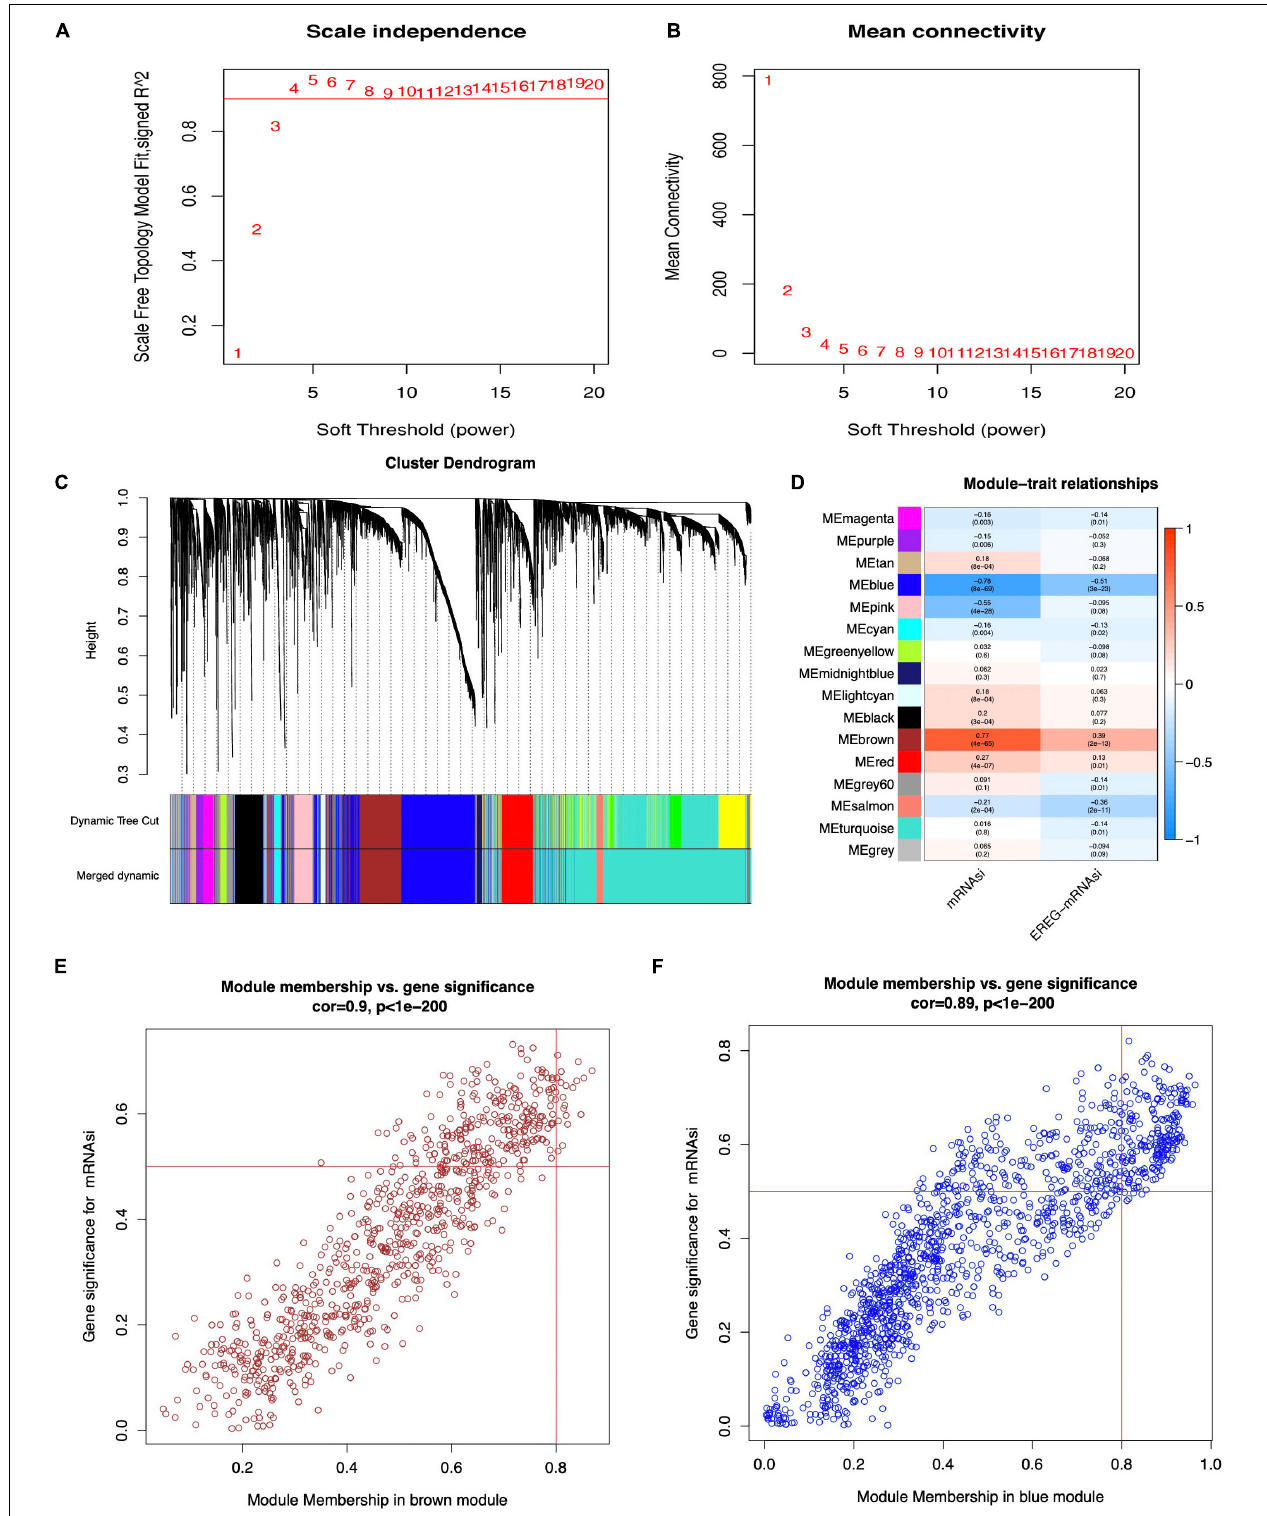
FIGURE 2 | Weighted gene co-expression network of STAD. (A,B) Soft threshold to identify the WGCNA module. (C) The cluster dendrogram of co-expression modules in STAD. (D) Correlation between the gene module and clinical traits, including mRNAsi and EREG-mRNAsi. (E,F) Scatter plot of module eigen genes in the blue and brown co-expression